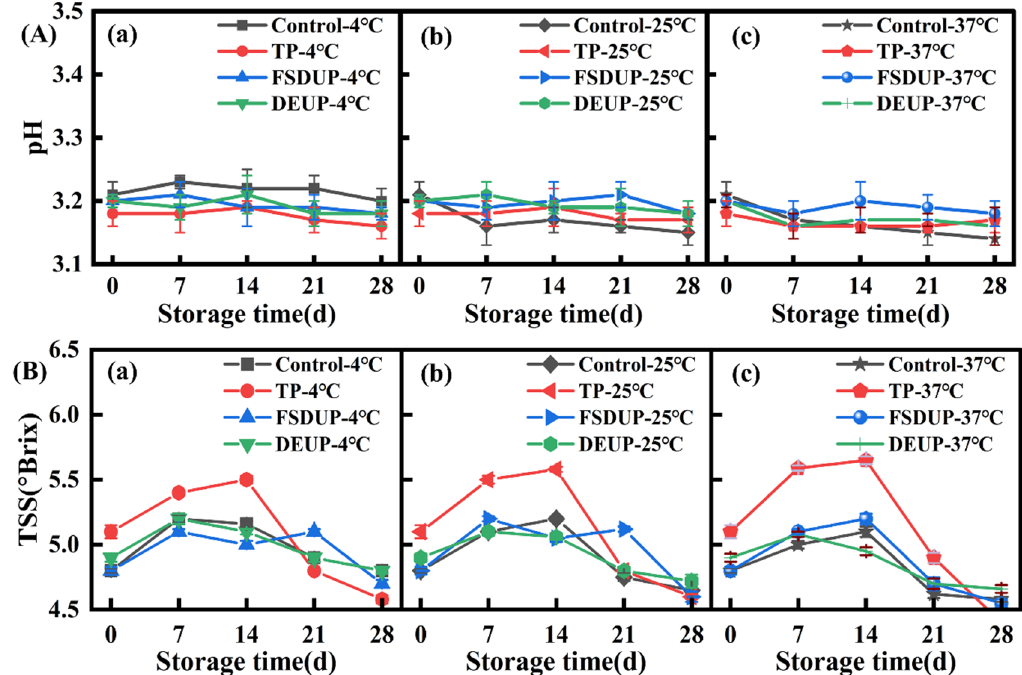
Figure 2. Changes in pH ( A ) and total soluble solids ( B ) of strawberry clear juice during storage after thermal pretreatment and multi-mode thermosonication. TSS: total soluble solids; TP: thermal pretreatment; FSDUP: flat sweep-frequency dispersive ultrasound pretreatment; DEUP: dual-frequency energy-gathered ultrasound pretreatment.